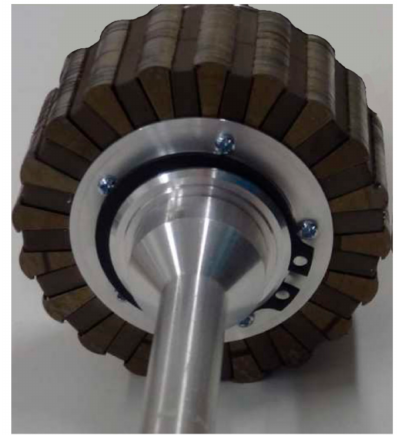
Figure 5. View of the designed through shaft.